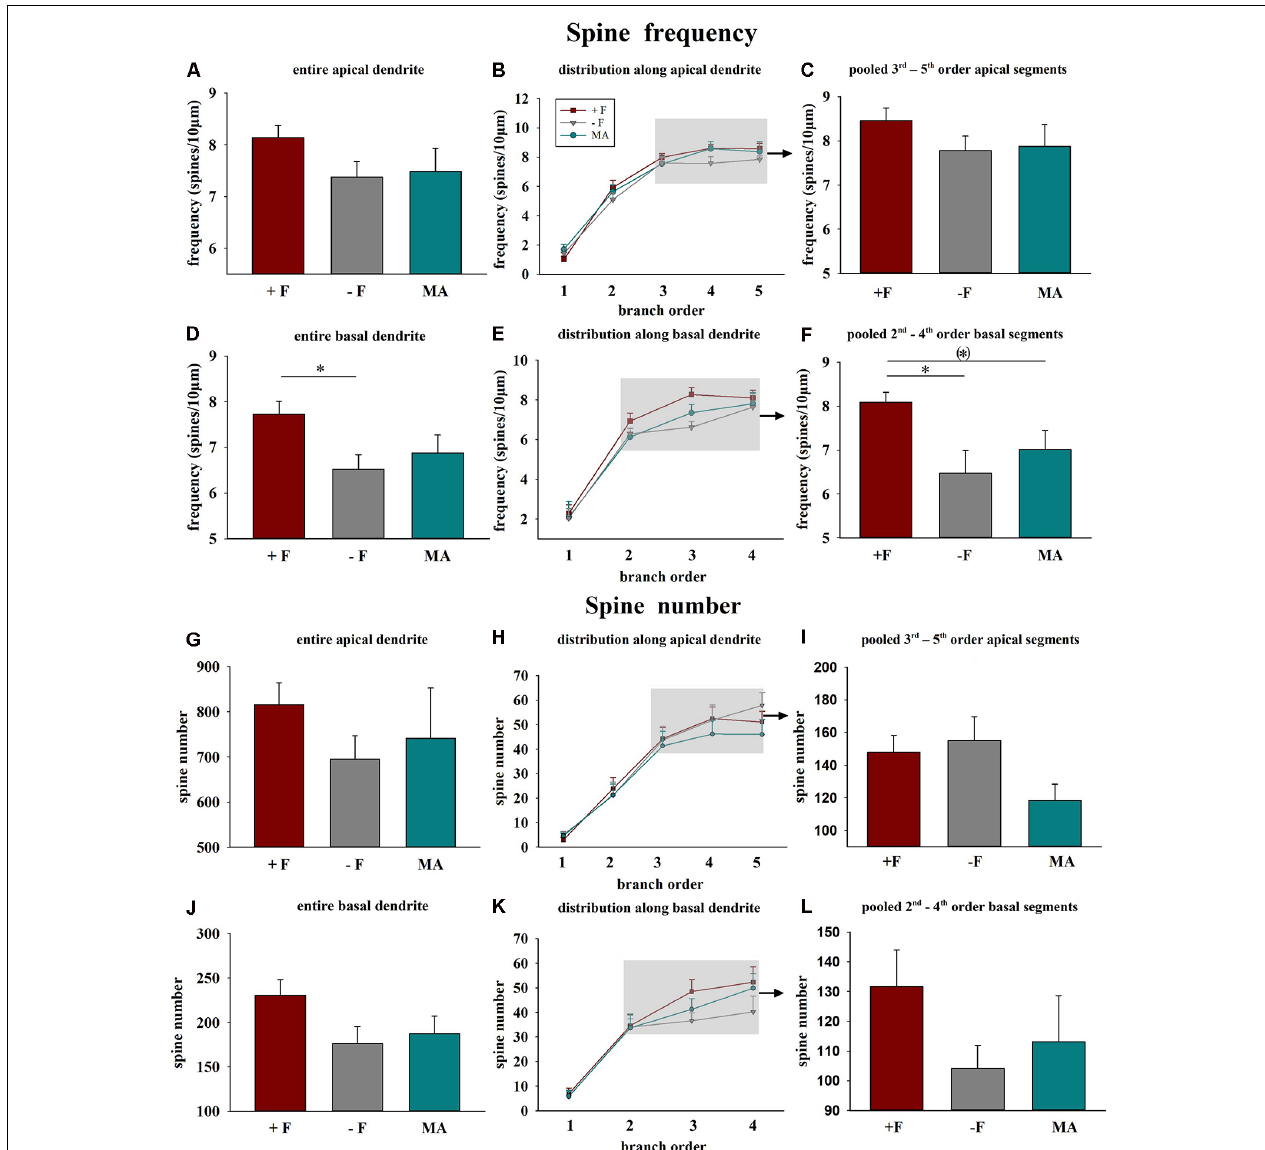
FIGURE 2 | Effects of different rearing conditions on dendritic spine frequency and spine number in male degu offspring. (A,D,G,J) Mean dendritic spine frequency and spine number for entire apical (A,G) or basal dendrites (D,J) . (B,E,H,K) Distribution of spine frequency and spine number within the individual dendritic segments (branch orders) along apical and basal dendrites; rectangles in figures in the central column indicate the branch orders used for pooled segment analysis. (C,F,I,L) Mean spine frequency and spine number of pooled 3rd to 5th branch order segments in apical and the 2nd to 4th branch order segments in basal dendrites. +F, male and female biparental control group; − F, fatherless single mother group; MA, female biparental (mother and aunt) group. ∗ p ≤ 0.05; ( ∗ ) p ≤ 0.1, SNK post hoc test.